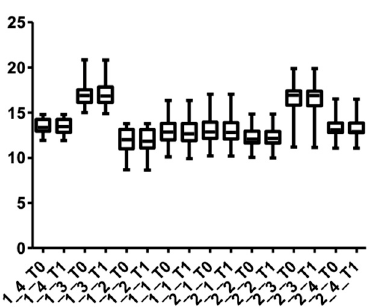
Figure 14. Root length distribution for mandibular teeth at T0 and T1.